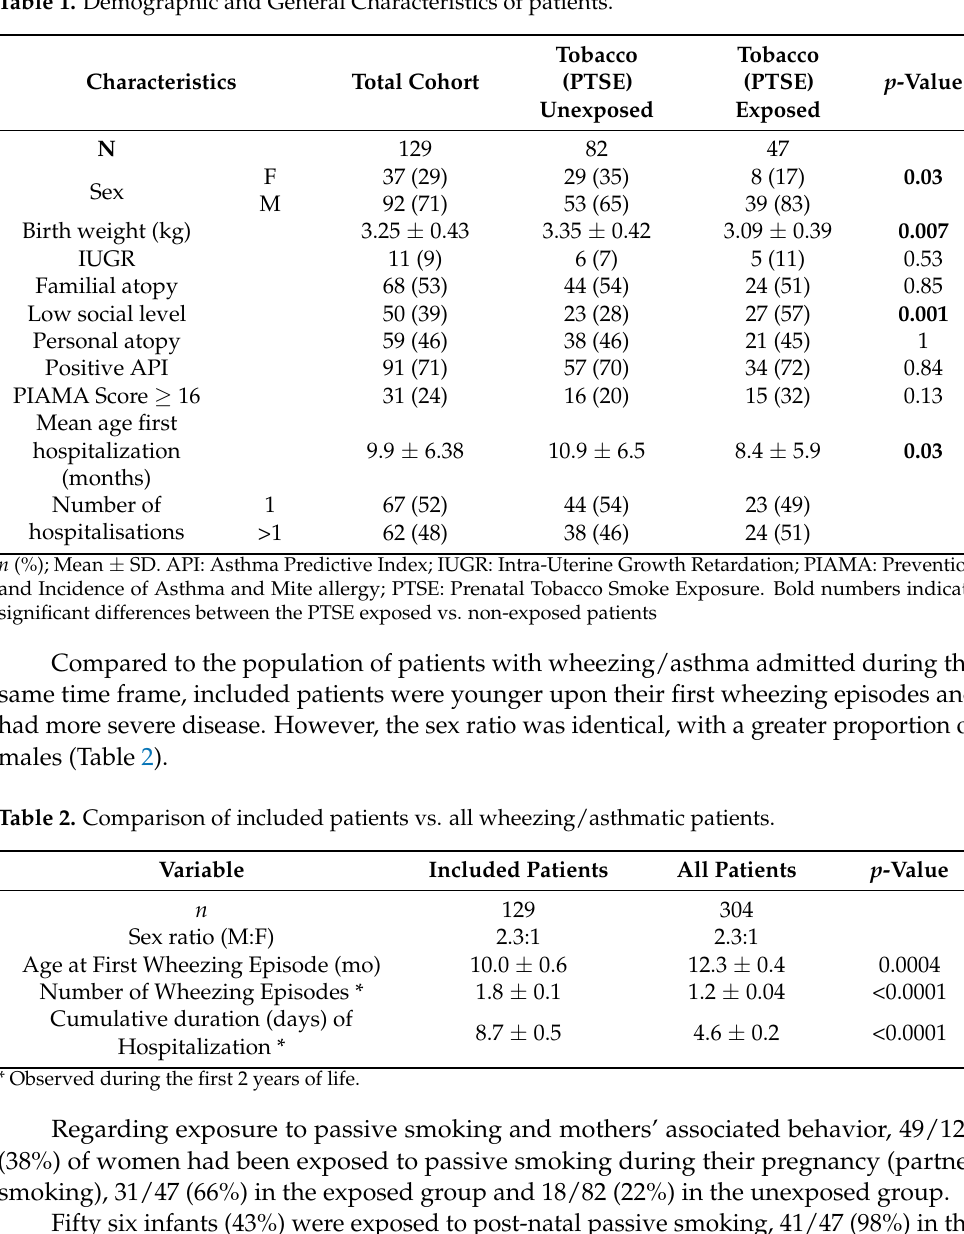
Table 1. Demographic and General Characteristics of patients.